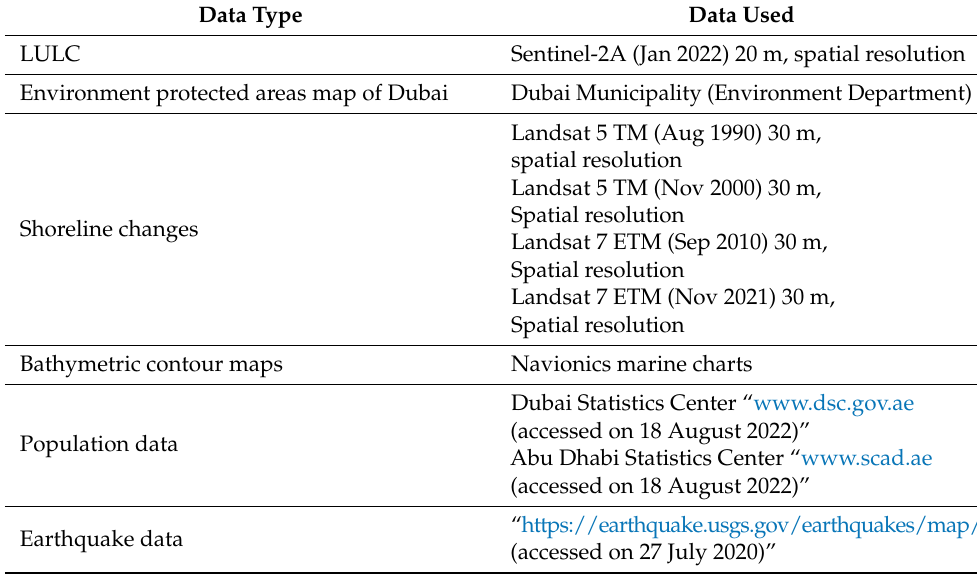
Table 1. Data utilized for various